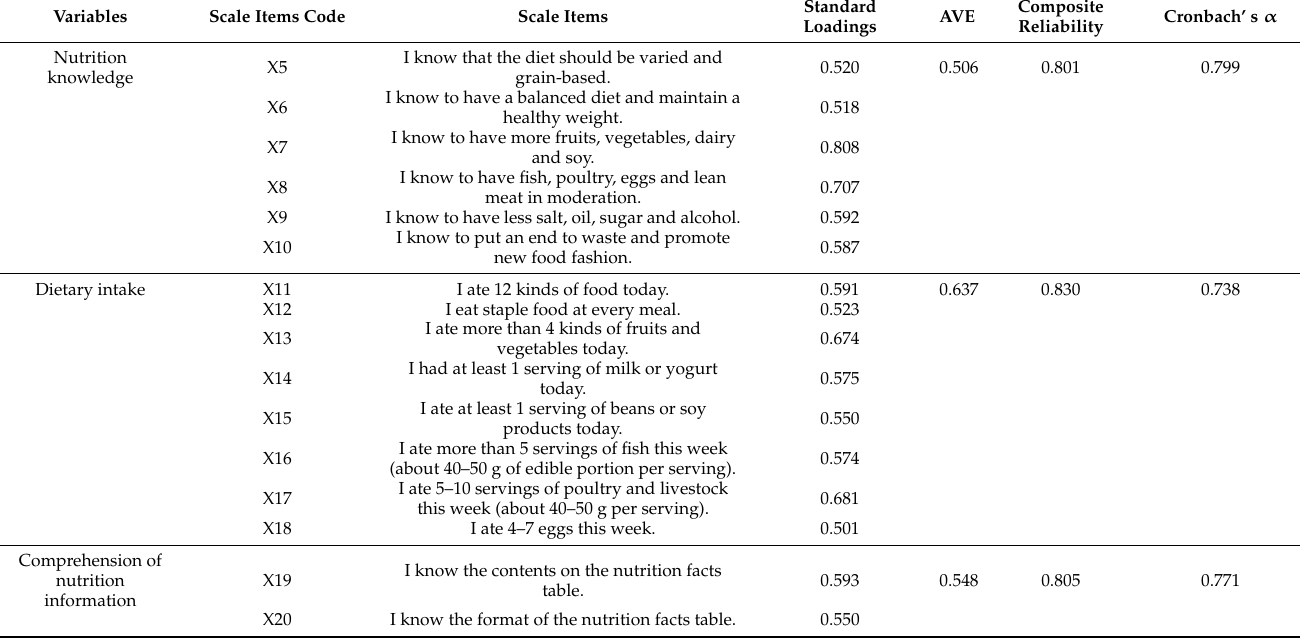
Table 5. Factor loadings and convergent validity